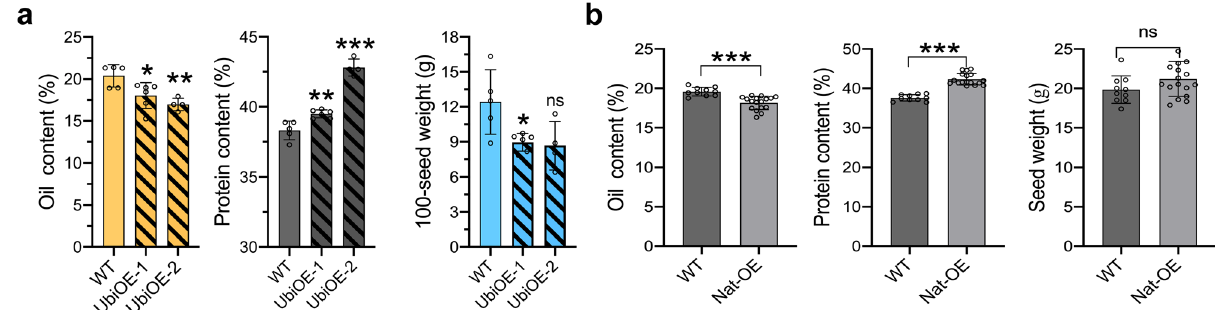
Fig. 3 Seed oil and protein content and weight in transgenic soybean overexpressing (OE) POWR1 − TE . a Seed protein, oil, and weight of T2 plants from each of the two transgenic events containing Ubi-promoter driven POWR1 − TE cDNA (Ubi-OE) ( n = 4 – 6). Unpaired t -test p values = 0.025, 0.0026 for oil content; 0.0036, <0.0001 for protein content; 0.0158, 0.0604 for seed weight. b seed protein, oil content, and 100 seed weight of T1 plants containing native promoter driven POWR1 − TE cDNA (Nat-OE) from 18 independent transgenic events ( n = 18). Unpaired t -test p values = <0.0001 for oil content, <0.0001 for protein content, 0.1095 for seed weight. Statistical signi fi cance was determined by two-tailed unpaired Student ’ s t test. Source data are provided as a Source Data fi le.